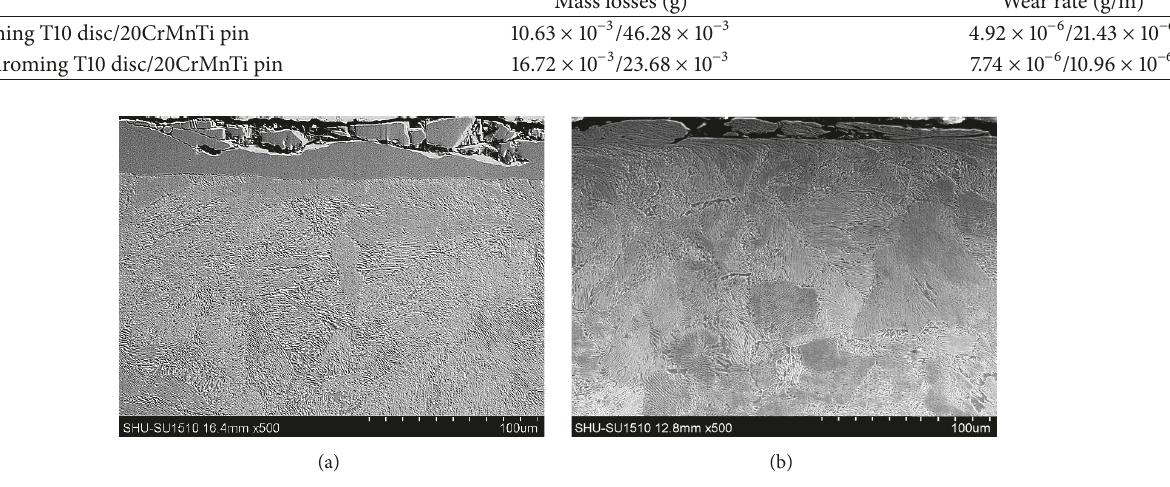
(ii) 100 ∼ 20 𝜇 m from the Surface. The deformation layer